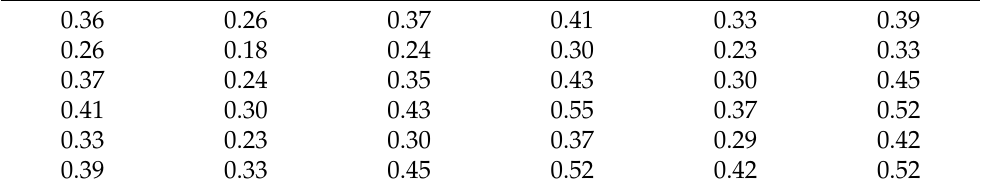
(cid:104) (cid:105) ˆ A ( E ,4 ) ( 0,1 ) associated with results reported in Table 4.